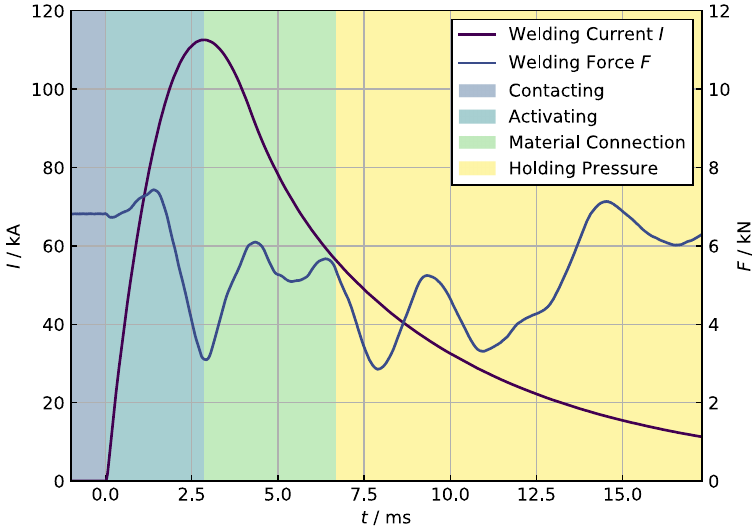
Figure 1. Characterization of a capacitor discharge welding process and input data for